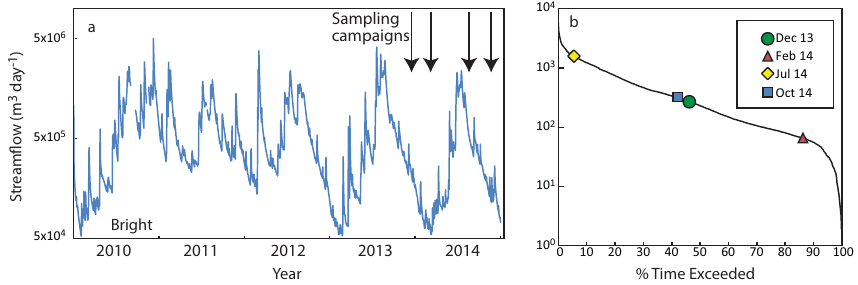
Figure 2. (a) Flow of the Ovens River at Bright between 2009 and 2014, arrows show timing of sampling campaigns. (b) Flow duration curve for Bright. Data from Department of Environment Primary Industries